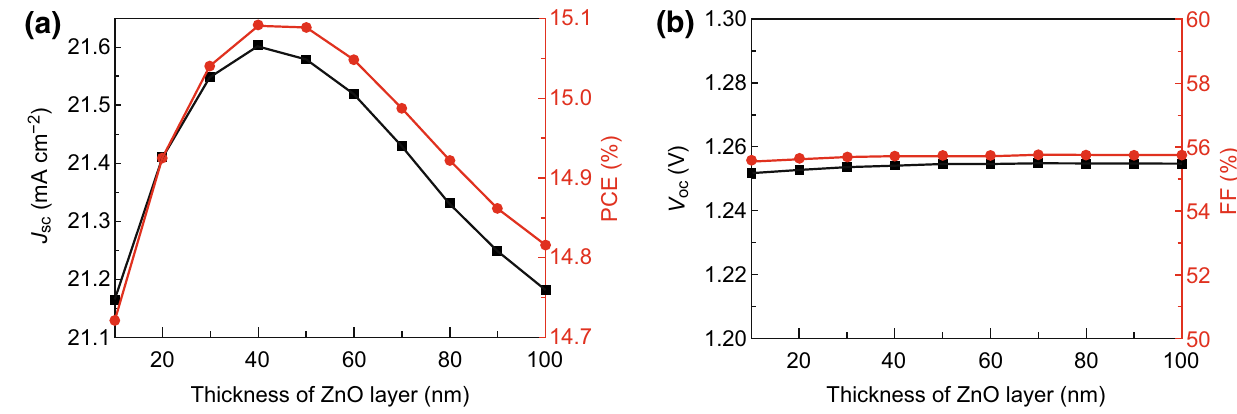
Fig. 4 Device parameters as a function of the thickness of ZnO for the CsPbI 3 -based PSC with a single-layer ZnO